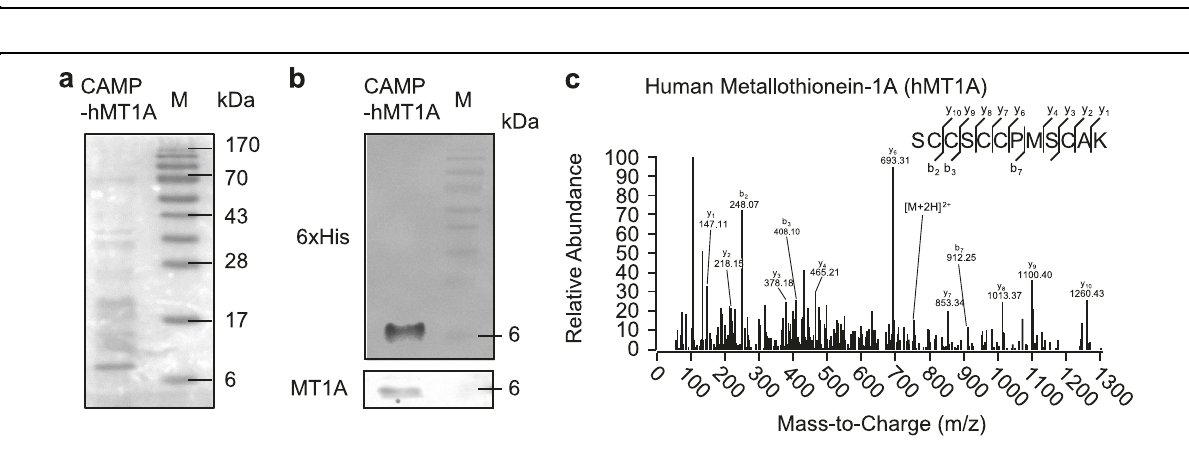
Fig. 3 Preparation of CAMP-hMT1A recombinant protein. CAMP-hMT1A protein was expressed in E. coli in the presence of 1 mM ZnSO 4 and puri fi ed by Ni-NTA af fi nity chromatography. a Coomassie blue staining. M molecular weight marker. b Western blot with 6xHis-tag